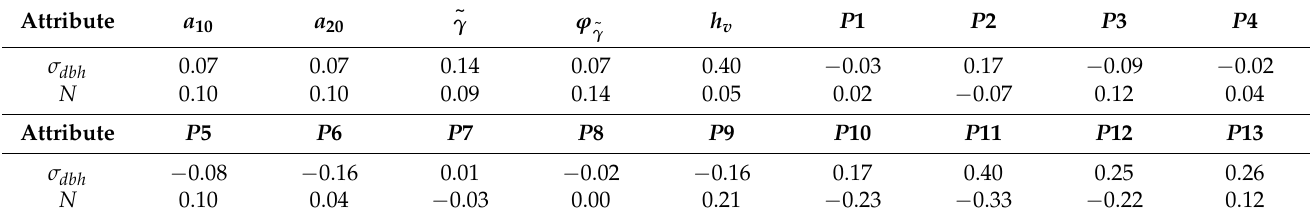
Table 3. Correlation coefficients of known coherency ( (cid:101) γ , ϕ ( h v ) , Legendre coefficients of a 10 and a 20 , and extracted PCT parameters of P 1– P